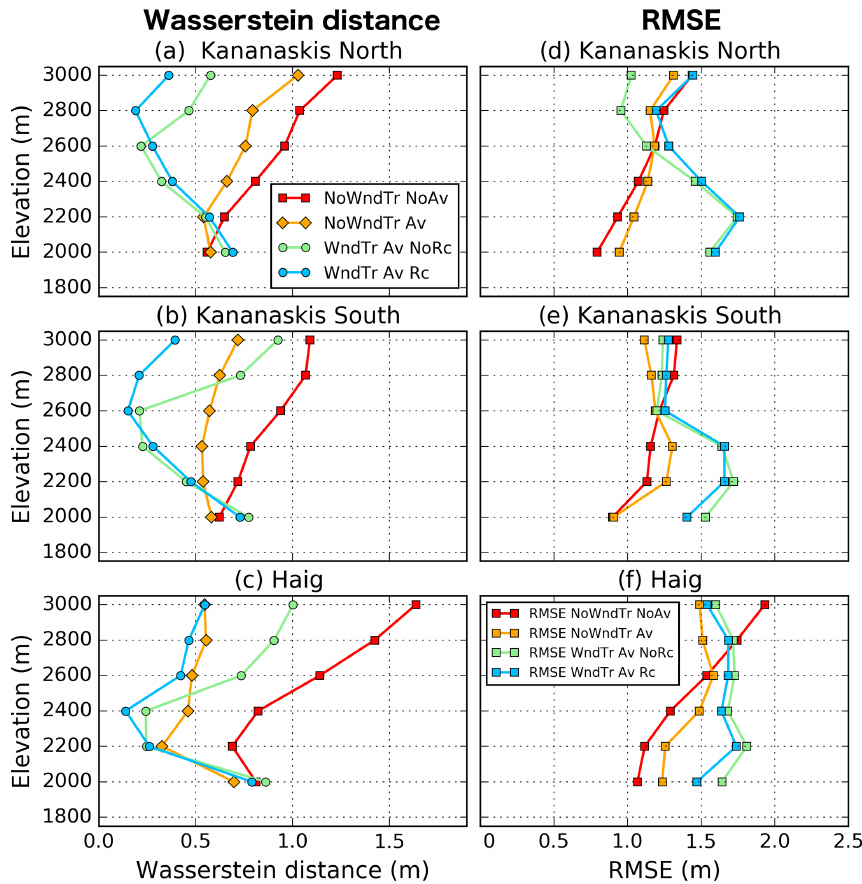
Figure 8. Wasserstein distance and RMSE between observed and simulated snow depth distribution as a function of elevation for four CHM experiments and three sub-regions. The location of these sub-regions is shown in Fig.